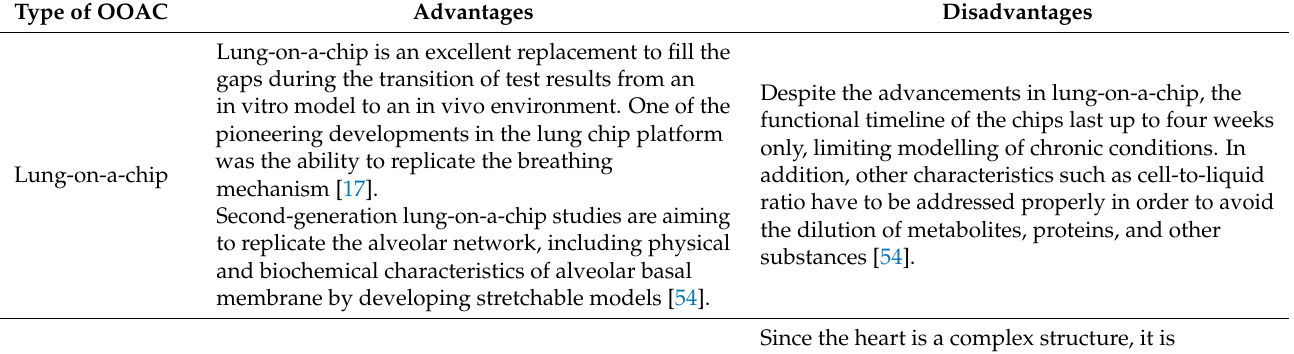
Table 2. The advantages and disadvantages of the discussed organ-on-chip